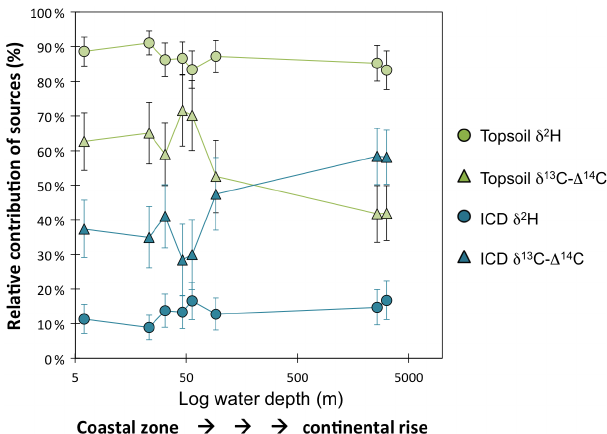
Figure 6. Contribution of OC from topsoil-PF (green) and ICD-PF (blue) sources to surface sediments along a shelf-slope transect in the Laptev Sea (see also Bröder et al., 2016b for further transect in- formation), calculated with a δ 13 C- (cid:49) 14 C (triangles) and leaf wax δ 2 H mixing model (circles). Stations are plotted against log wa- ter depth (m; see also Table 6) following the transect order from the coastal, nearshore, zone in the South (furthest left; TB-46, 6m depth) towards the continental rise in the North (furthest right; SW- 01, 3146m depth). Topsoil (cid:49) 14 C endmember values are corrected for cross-shelf transport time (see Sect.